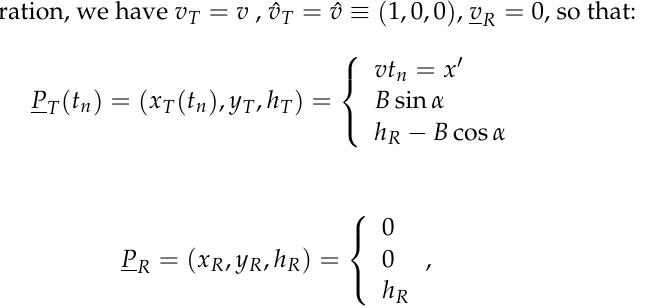
Figure 4. Geometry of the one-stationary bistatic SAR configuration: ( a ) 3D view; ( b ) cross-track plane view.